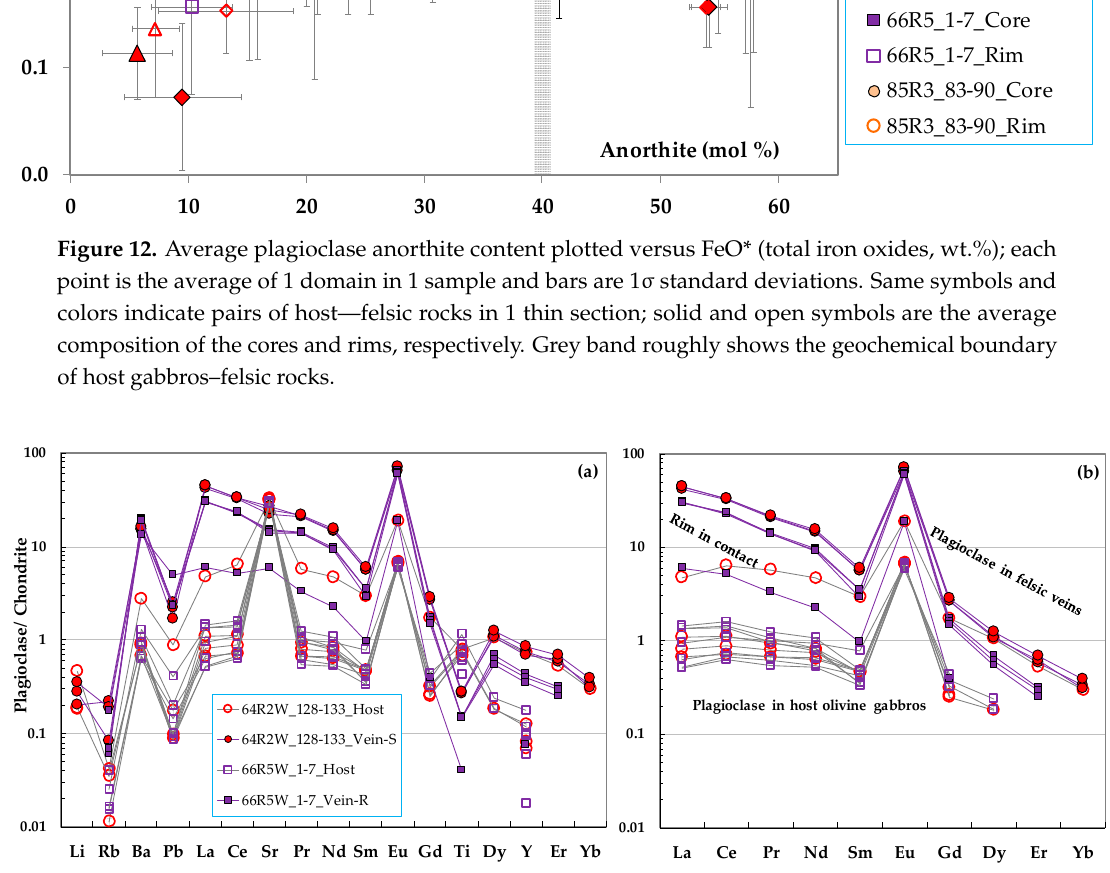
Figure 13. Chondrite-normalized trace ( a ) and REE ( b ) abundances of plagioclase in the host gabbros and felsic veins—Hole U1473A.